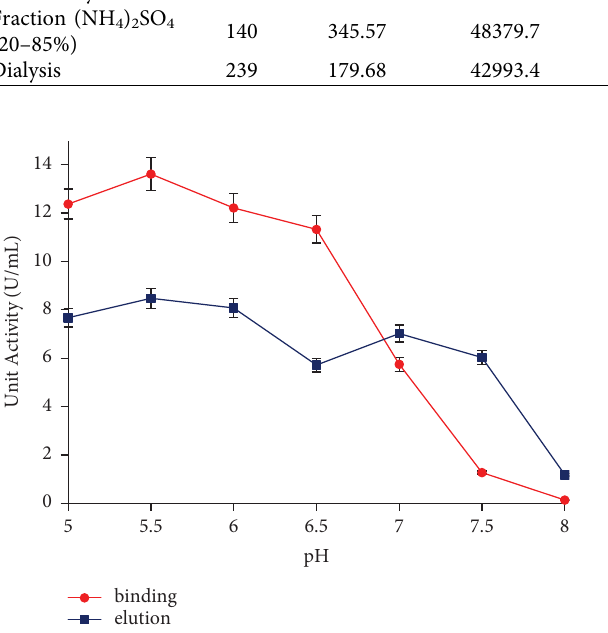
Figure 2: Binding buffer pH for enzyme immobilization. The data are presented as mean ± SD; n � 2; a significant difference � p < 0 . 05. The error bars represent standard deviations from two replicates measurements.